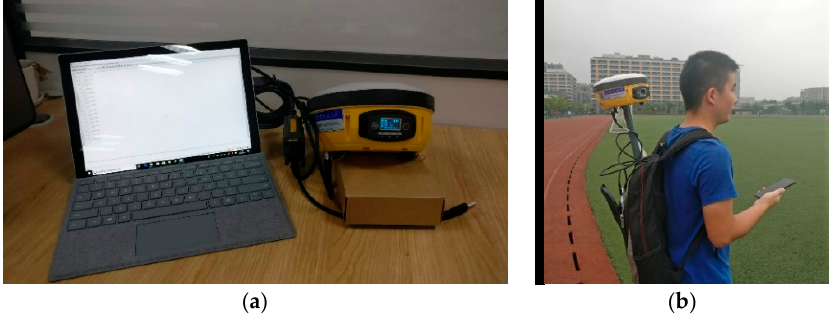
Figure 13. DGPS Device and the Wear Mode of Playground Experiment. ( a ) The DGPS device and the data storage device (Surface tablet PC); ( b ) The specific equipment for playground experiment.